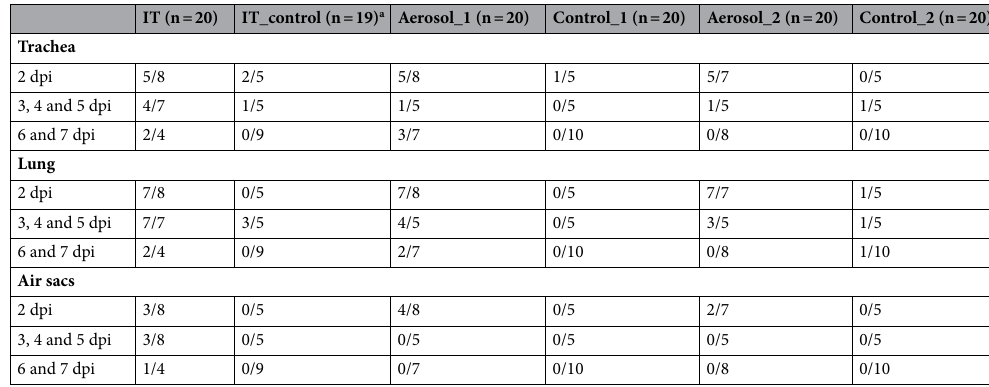
Table 6. Recovery of Escherichia coli from the respiratory organs. Number of birds positive for E. coli in pure culture or with E. coli domination at various dpi. a One animal in IT_control was euthanised due to chronic pododermatitis. dpi days post-infection, IT intratracheal, n